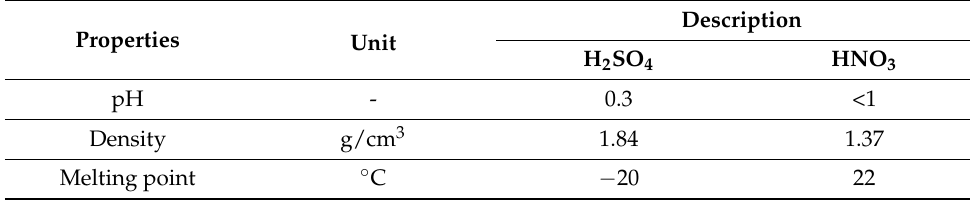
Table 2. Physical and thermal properties of H 2 SO 4 and HNO 3 .